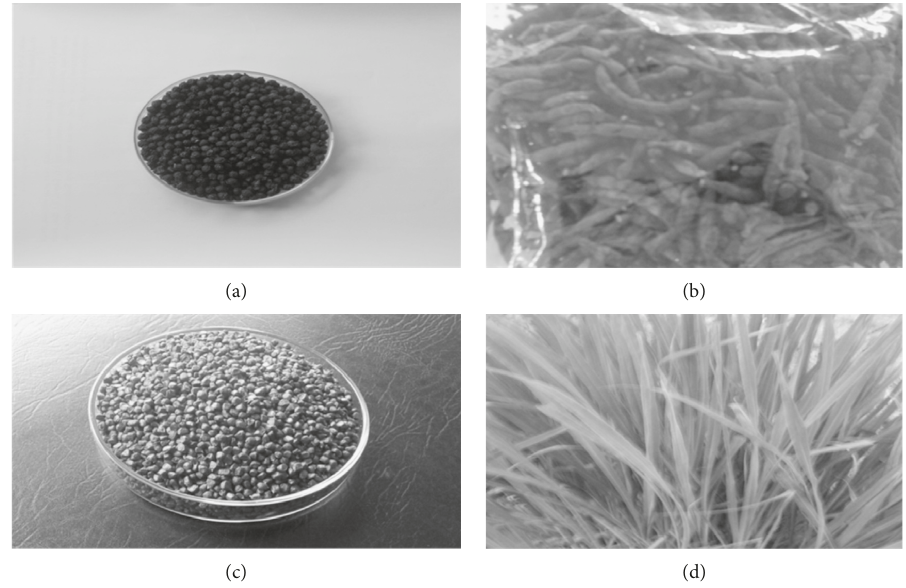
Figure 2: Botanical materials used: (a) black pepper ( Piper nigrum ), (b) Ethiopian pepper ( Xylopia aethiopica ), (c) grains of paradise ( Aframomum melegueta ), and (d) lemon grass ( Cymbopogon citratus ).